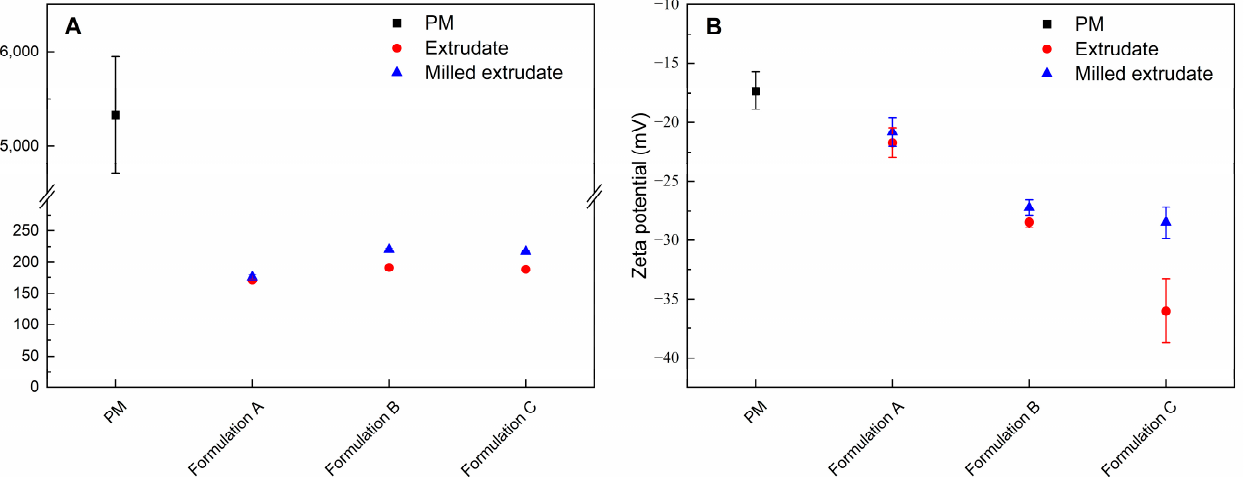
Figure 4. The particle size determination ( A ) and zeta potential dissolution ( B ) of the physical mixtures of ritonavir/PVPVA/Span 20 (PM), extrudates, and milled extrudates. (mean ± S.D., n = 3.).